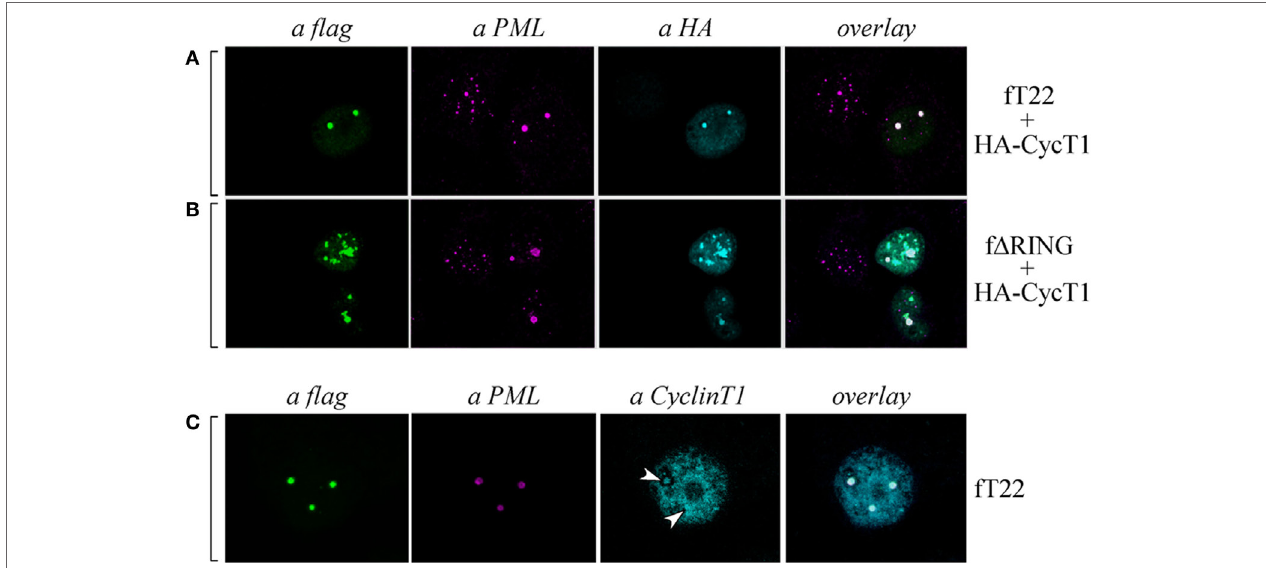
FigUre 7 | cyclin T1 and promyelocytic leukemia (PMl) are recruited in tripartite motif-containing protein 22 (TriM22)-containing nuclear bodies . (a,B) Hep-2 cells were transfected with hemagglutinin (HA)-tagged CycT1, with flag-tagged TRIM22 (fT22) or with flag-tagged TRIM22- Δ RING (f Δ RING) expression vectors as indicated on the right, and incubated with the antibodies listed on the top. PML was detected with anti-PML rabbit polyclonal antibody followed by AlexaFluor 546-conjugated antibody. Cyclin T1 was detected with anti-HA monoclonal antibody (mAb) followed by AlexaFluor 633-conjugated antibody. Flag- TRIM22 and flag Δ RING were detected by direct staining with fluorescein isothiocyanate (FITC)-conjugated anti-flag antibody. (c) Hep-2 cells were transfected with with flag-tagged TRIM22 (fT22) expression vector as indicated on the right, and incubated with the antibodies listed on the top. PML was detected with anti-PML mouse mAb followed by AlexaFluor 546-conjugated antibody. Cyclin T1 was detected with anti-Cyclin T1 rabbit polyclonal antibody followed by AlexaFluor 647-conjugated antibody. Flag-TRIM22 was detected by direct staining with FITC-conjugated anti-flag